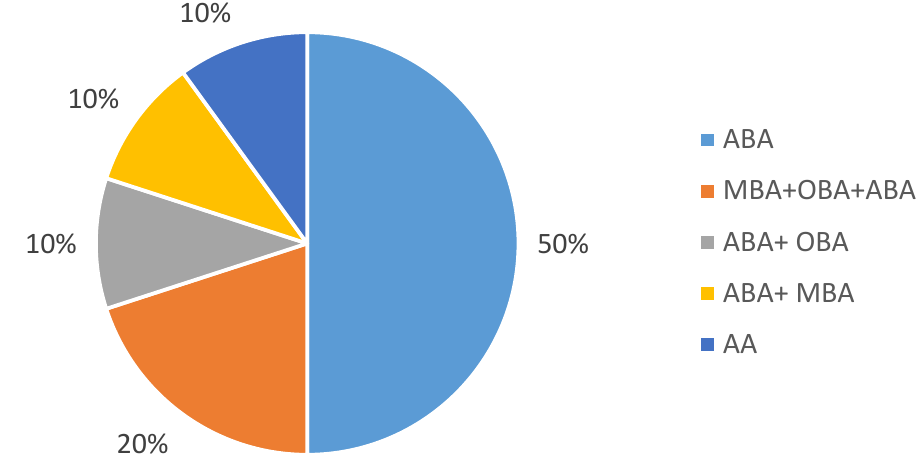
Figure 5. Distribution of output approaches used in studies on the commercialization